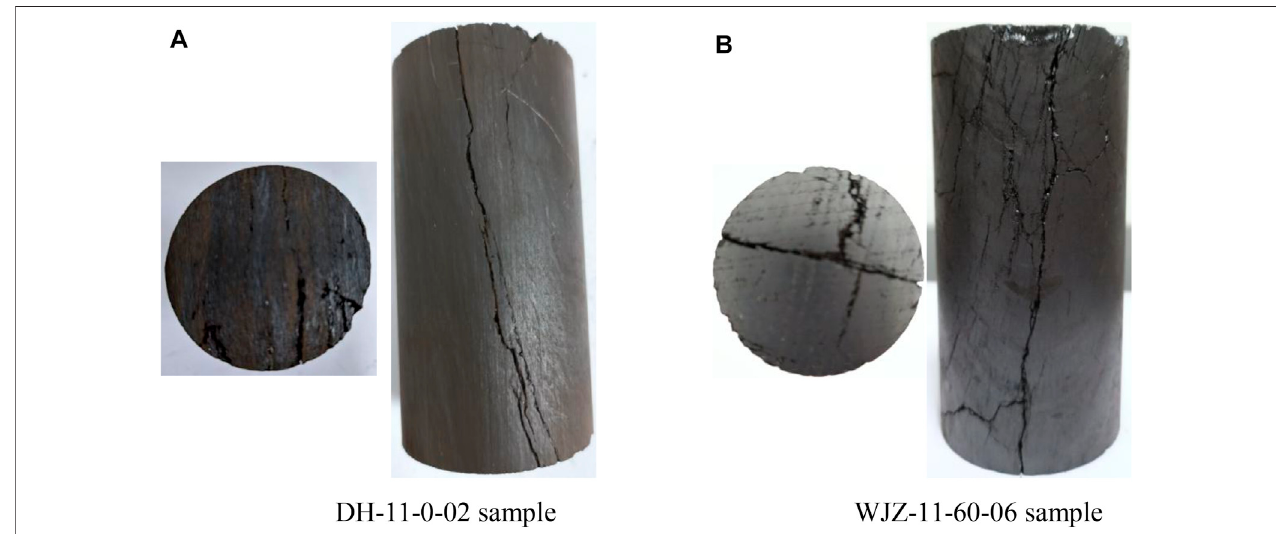
FIGURE 7 | Coal sample with penetrating crack. (A) DH-11-0-02 sample. (B) WJZ-11-60-06 sample.